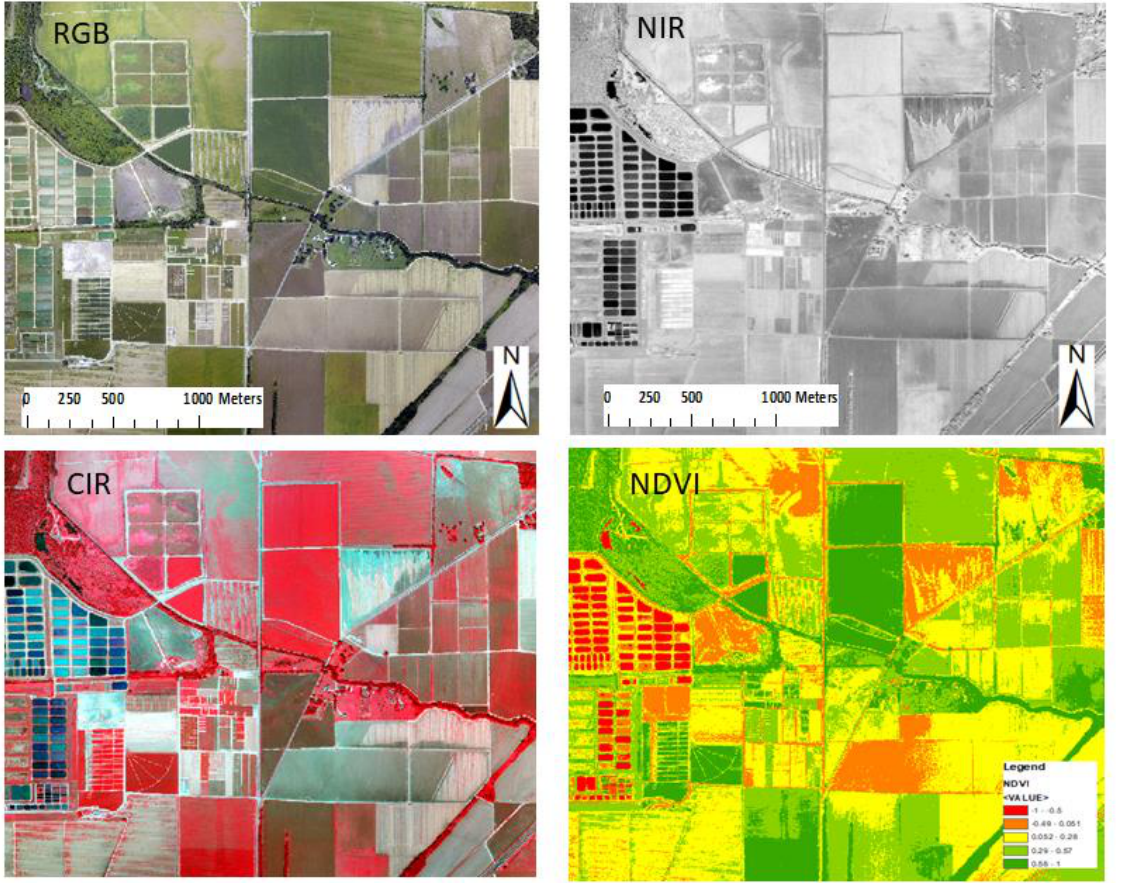
Figure 2. Orthomosaic images (2 September 2016) of the research farm area at Stoneville, Mississippi.